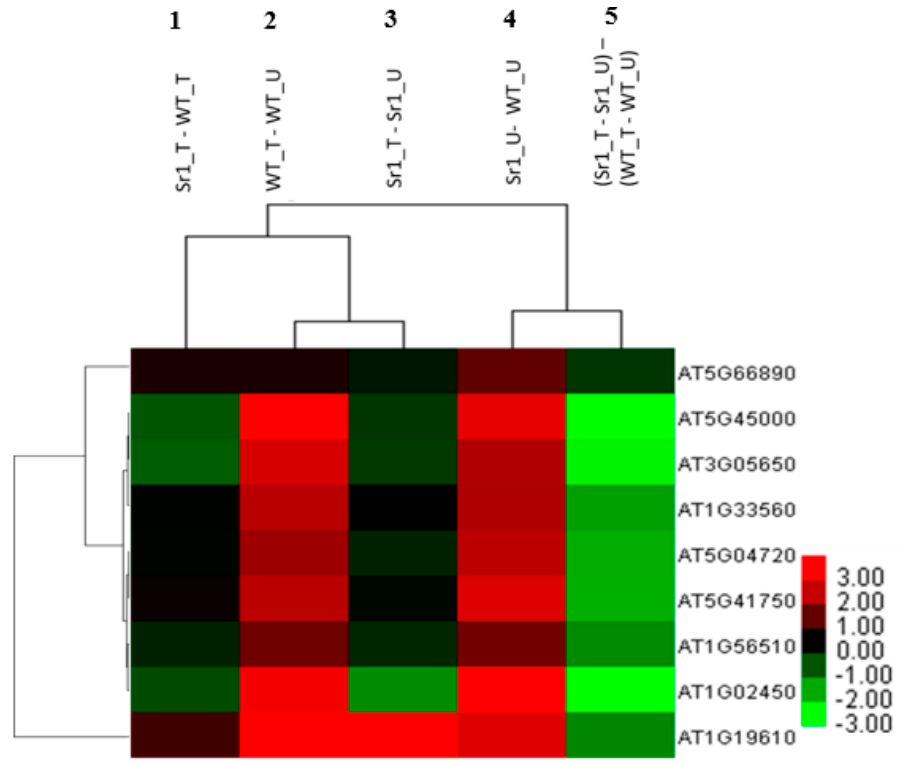
Figure 4. Hierarchical cluster analysis and heatmap indicating expression of defense-related DEGs between the genotype test and pathogen inoculation. The fold changes in gene expressions that increased and decreased in abundance are indicated in red and green, respectively. The intensity of colors increased as the difference in abundance increased. WT_U: absence of pathogen in WT; WT_T: 24 h after infiltration with Pst DC3000 in WT; Sr1_U: absence of pathogen in atsr1 mutants; Sr1_T: 24 h after infiltration with Pst DC3000 in atsr1 mutants.